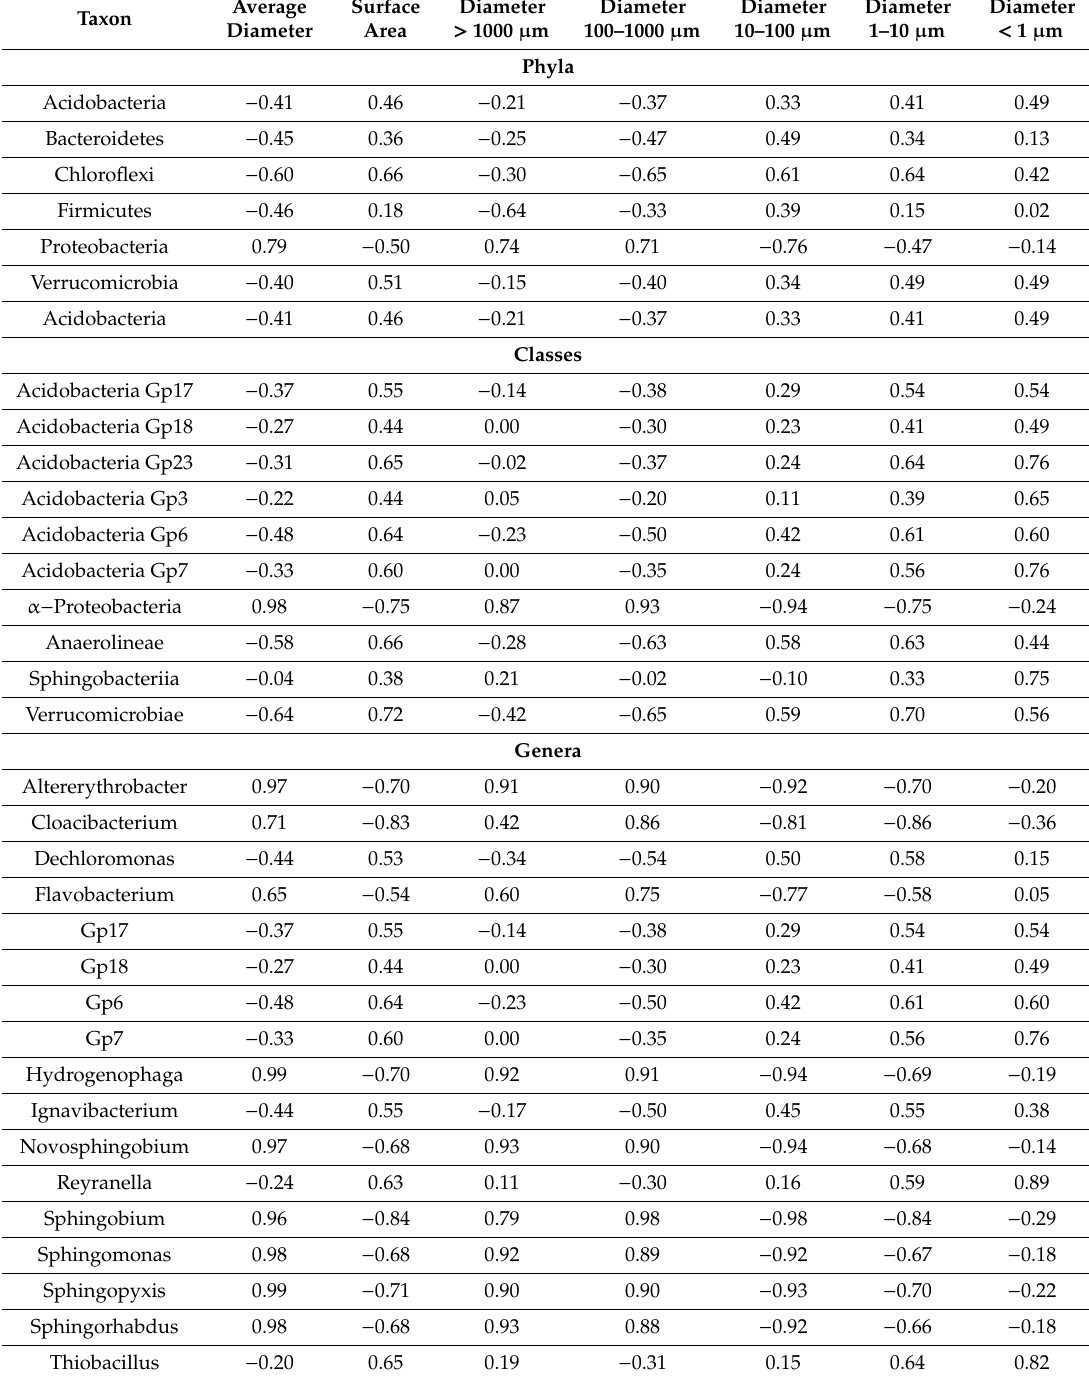
Table 3. Pearson’s correlation coe ffi cients between the relative abundances of various microbial taxa at phylum, class, and genus levels and the physical characteristics of particles in the sediments (diameter and surface area of particles, the proportion of di ff erent size fractions). Abundant taxa with correlation coe ffi cients > 0.5 or < − 0.5 are